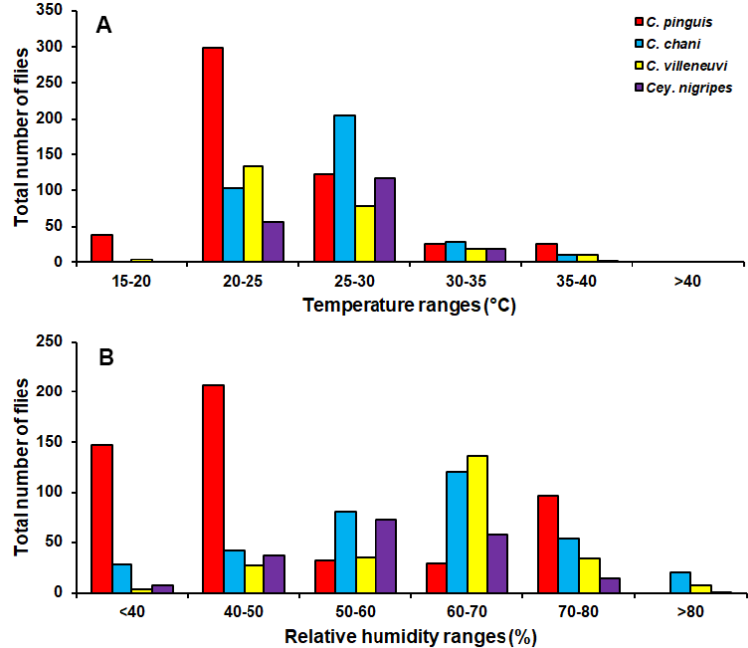
Figure 3. Total number of flies captured at different temperature ( A ) and relative humidity ranges ( B ).